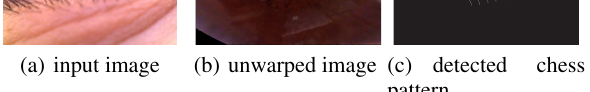
Figure 10 . Linearity and parallelism of an unwarped corneal sur- face image. The left image is the corneal surface image where the chess pattern is reflected. The middle image is the unwarped corneal surface image, which was generated to confirm the linearity and par- allelism. The right image shows the result obtained after detecting the chess pattern.